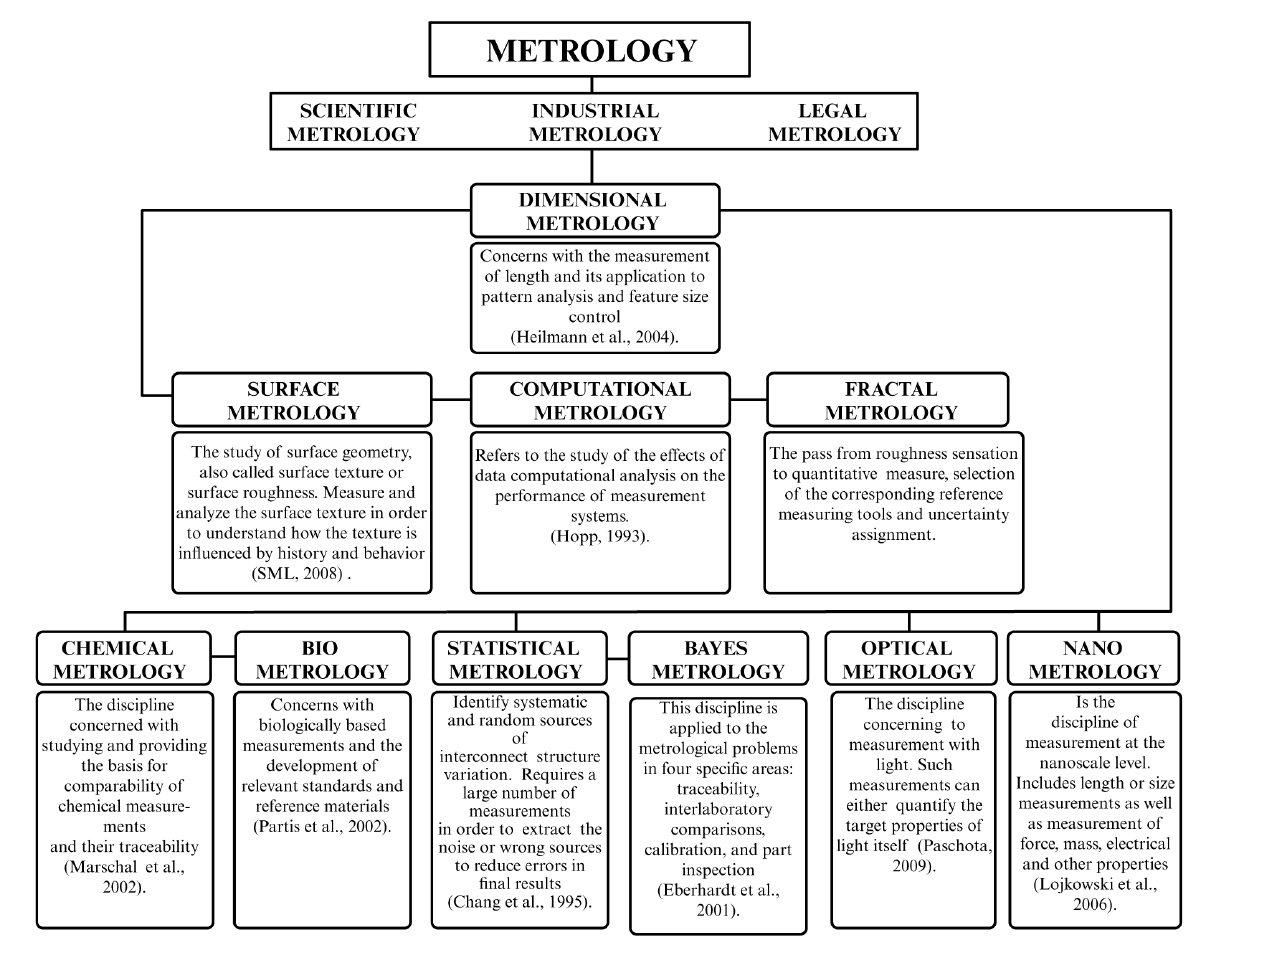
Fig. 1. Metrology division in